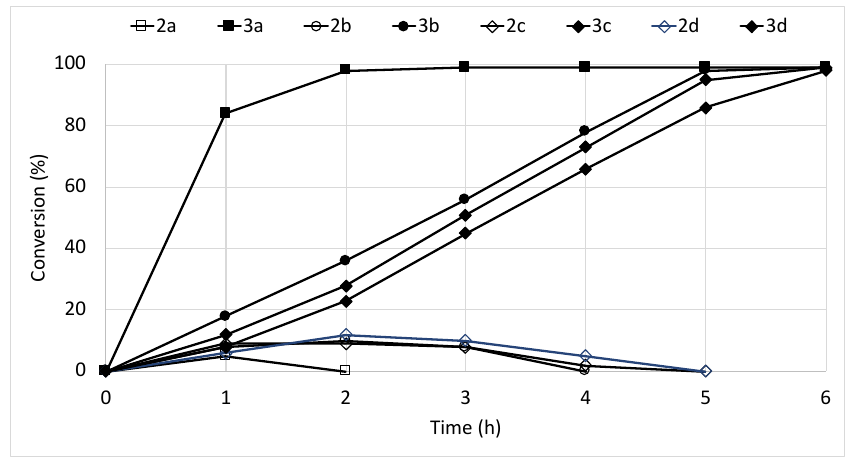
Figure 1. Time-course of the oxidation of achiral 2-substituted 1,3-diols 1a–d with immobilized cells of Acetobacter aceti 2000/28 in conventional shaken flasks (batch mode). Reaction conditions: 0.60 mmol of substrate, 2.0 g of alginate beads containing 500 mg dry weight of cells in 50 mL of acetate buffer (20 mM pH 6.0) at 28 °C.